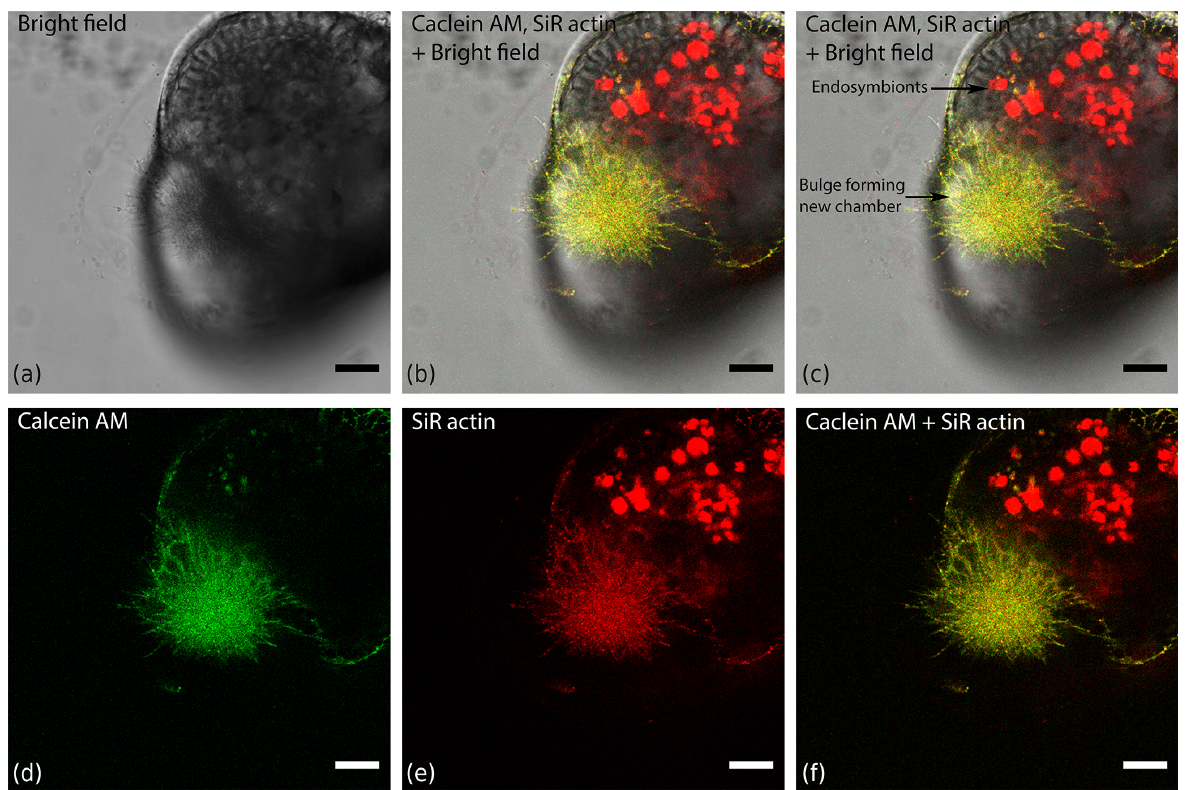
Figure 4. Organisation of actin within a finger-like structure preceding globopodium during chamber formation in Amphistegina lessonii , compared with localisation of cytoplasm stained with calcein red–orange AM. Images was obtained with a Leica SP5 inverted confocal microscope (scale bar